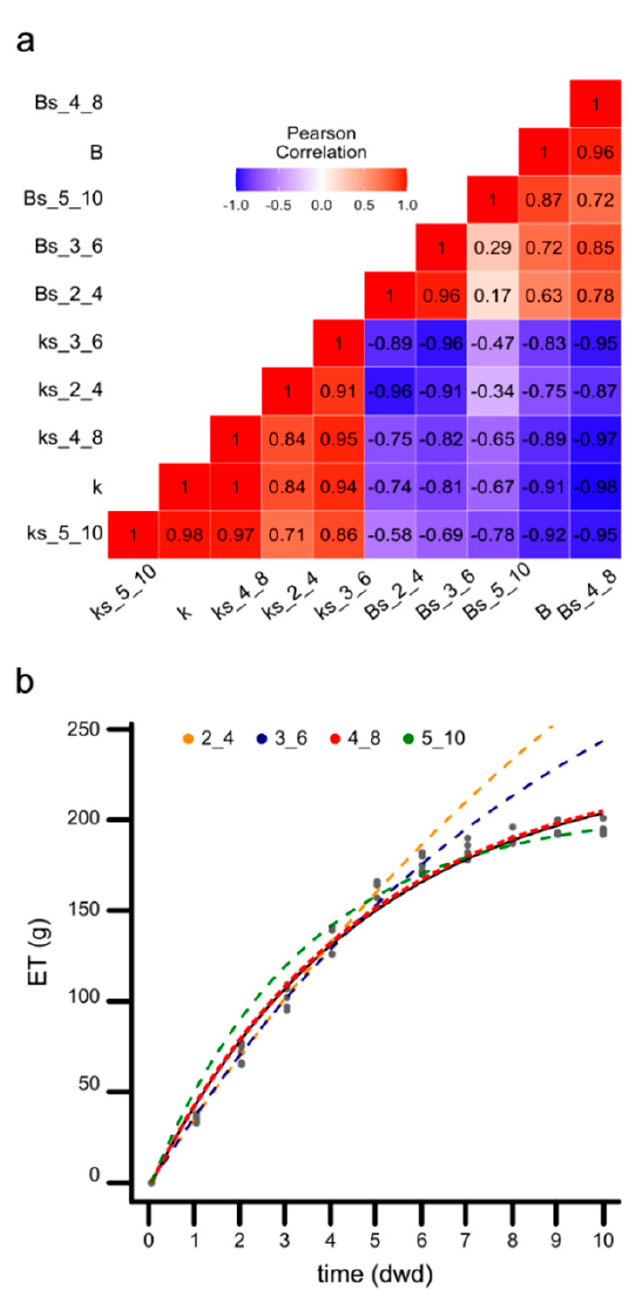
Figure 3. Minimum sampling requirements analysis and adjustment of model. ( a ) Relation between K or B estimated by the Gauss Newton method and the predicted K or B generated by analytic methods with two-time sampling, respectively. Axis indicates the parameters and the days of the sampling. ( b ) ET over time. Graphic representation of Equation (7) adjusted according to the data of the numeric (solid curve) or analytic methods (dashed colored curve). Colors indicate the two specific sampling days used for modeling the curve. Days of water deficit: dwd.